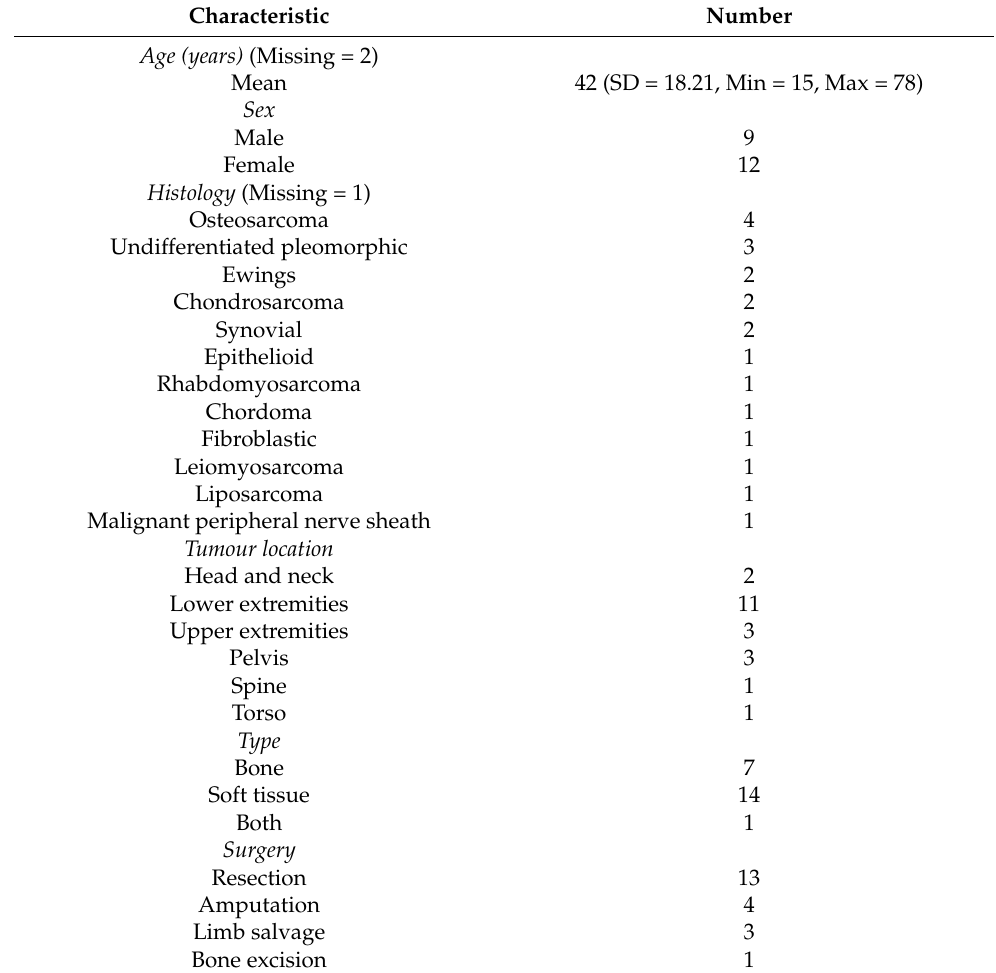
Table 1. Patient demographics ( n =